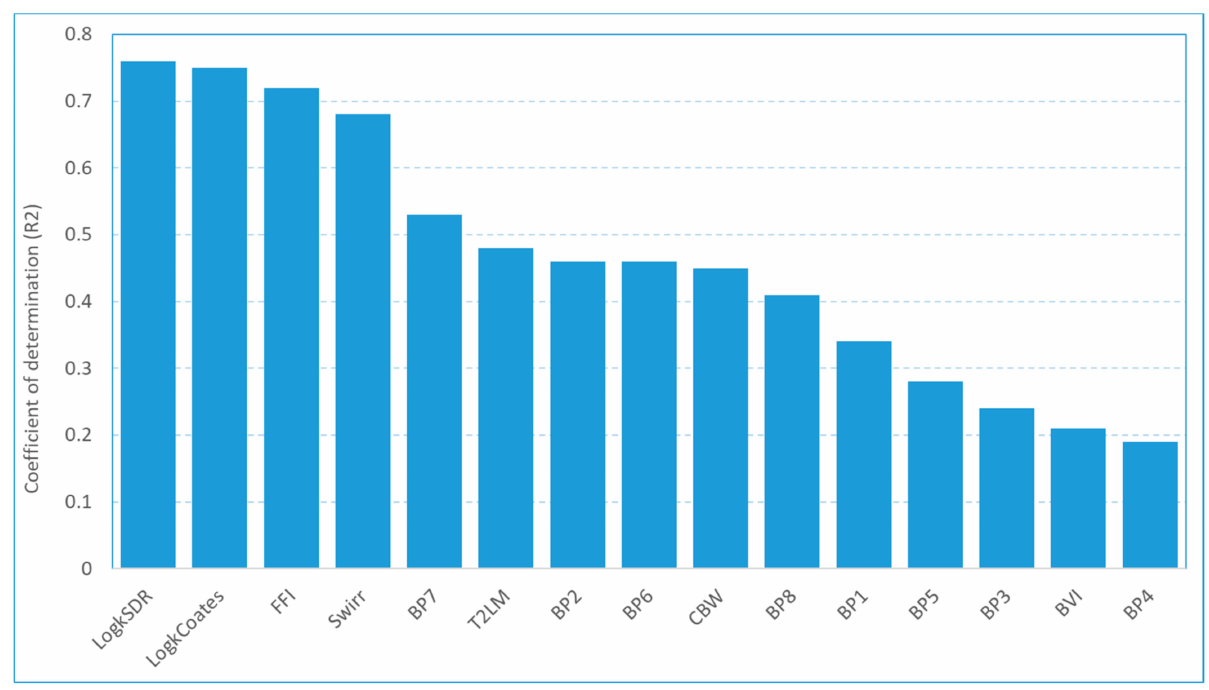
Figure 4. The coefficient of determination (R2) or the success of MRA in predicting NMR log